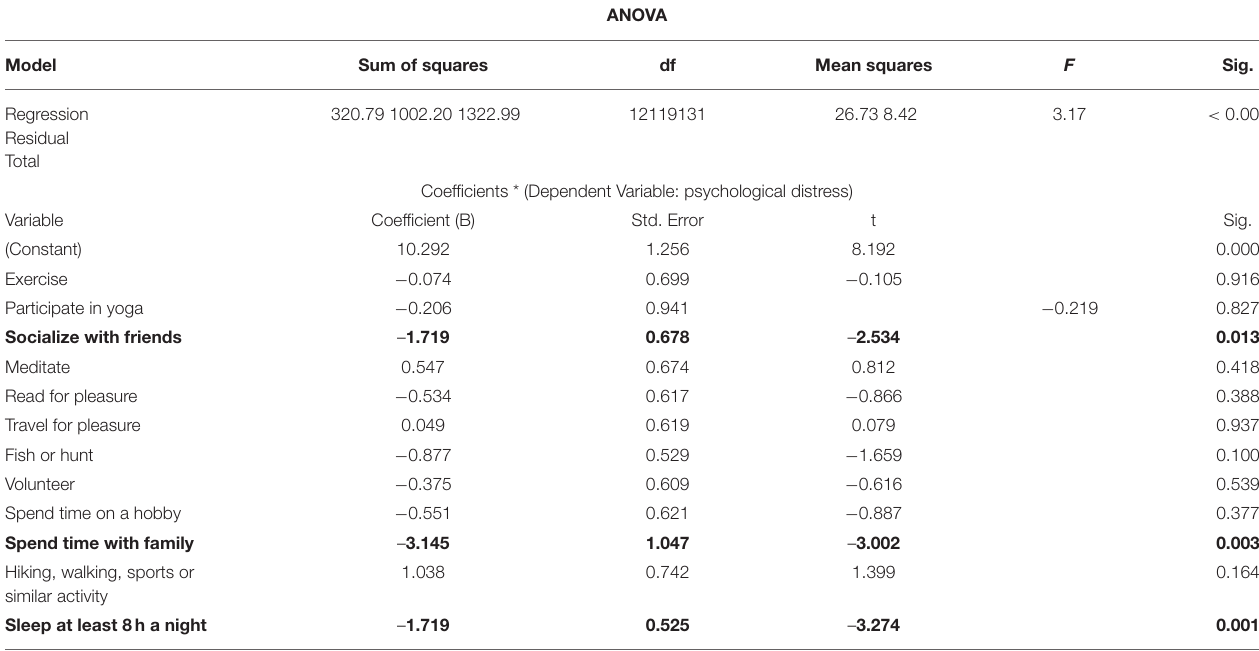
TABLE 9 | Results of the multiple linear regression model predicting psychological distress as a function of healthy